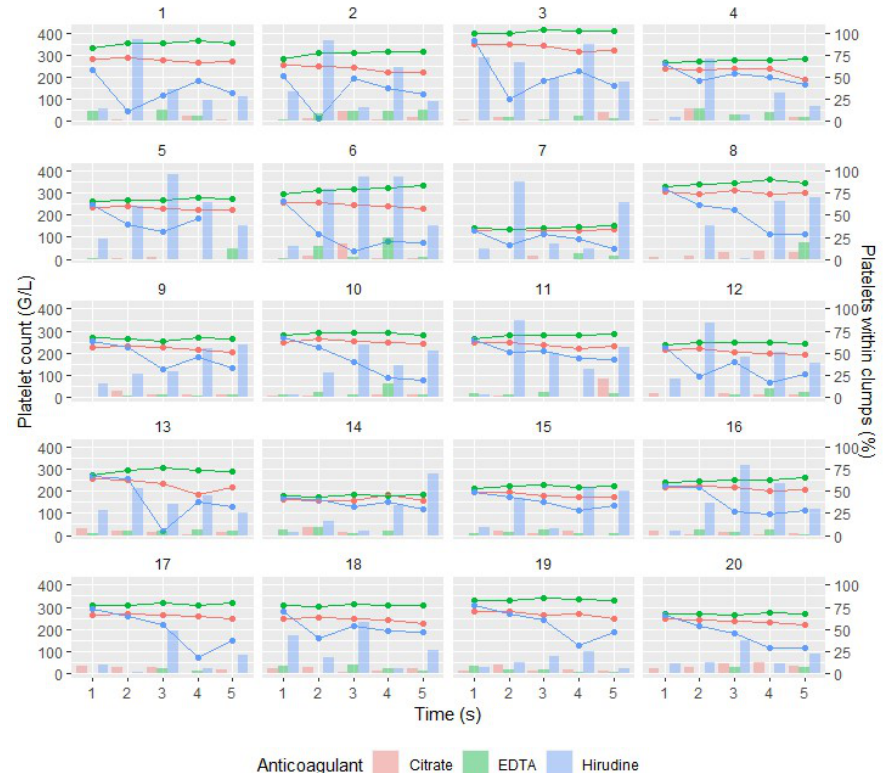
Figure 3. Platelet count measured by impedance method (lines) and percentage of platelets within clumps (bars) over time for each subject ( n = 20) and anticoagulant. Red lines/bars represent tests performed with blood samples anticoagulated with citrate, green lines/bars with EDTA and blue lines/bars with hirudin. We can observe that platelet count is partly varying in relation to the percentage of platelets within clumps.